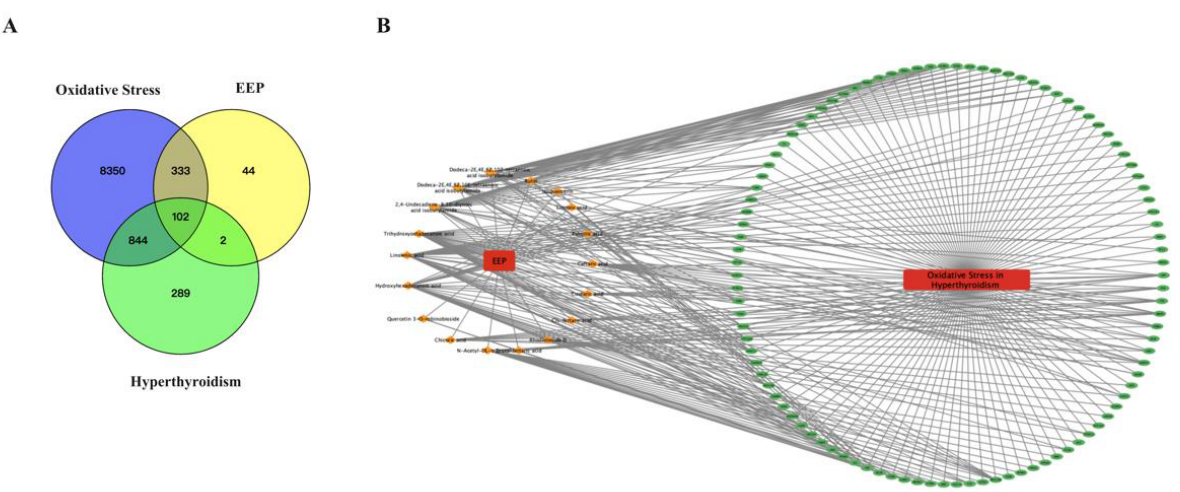
Figure 8. Influence of antioxidative mechanism of targets for EEP antioxidative against hyperthyroidism. ( A ) Venn diagram of EEP, oxidative stress and hyperthyroidism intersection targets; ( B ) EEP-compound–hyperthyroidism-oxidative stress–target network.